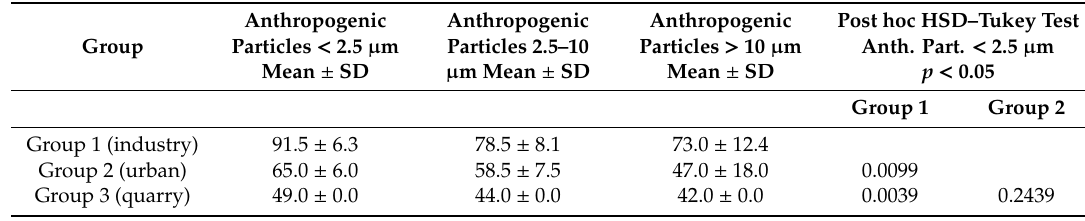
Figure 3. Back-scattered electrons (BSE) image of P . nigra leaves taken from site 16 and representative EDX spectra. Spectrum 1 —silica (quartz); spectrum 2 —Ca / P / K spherule; spectrum 3 —alkali feldspar (illitized); spectrum 4 —iron oxide; spectrum 5 —silicate slag / ash; spectrum 6 —Cu-Fe sulfide. Table 1. Mean and standard deviation (SD) of contribution atmospheric particles (%) adsorbed on P . nigra leaves from three groups: 1 industry / smelters, 2 urban, 3 industry / quarry sites. N = 9; probability level (P) for homogeneity of variance in ANOVA and for post hoc test between groups.